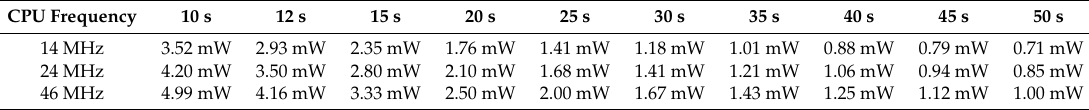
Table 7. Average power consumed in a 24 hour period by the BLE